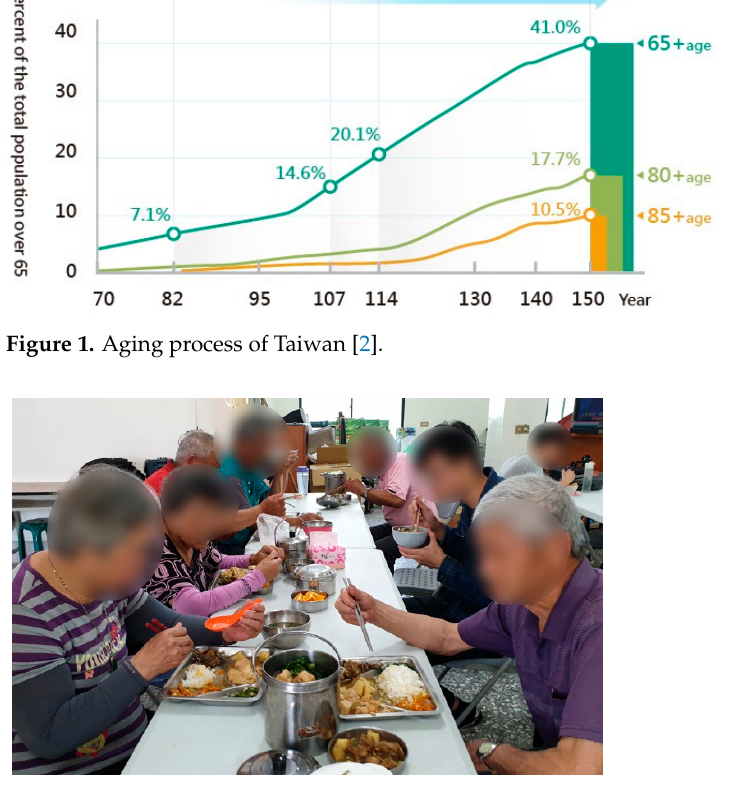
Figure 2. Older adults eat in the senior meal hall. (The image was taken by the